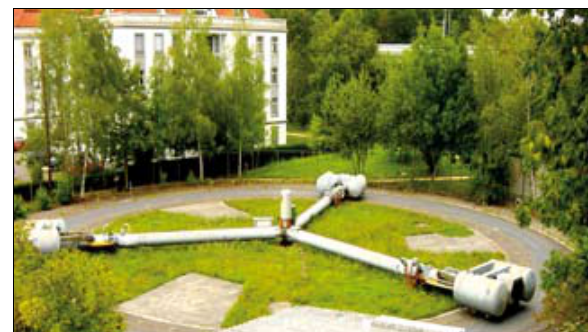
fig 6. Circular track Table 2. Material used in the test section on the circular track (Rabaiotti, Caprez 2006)